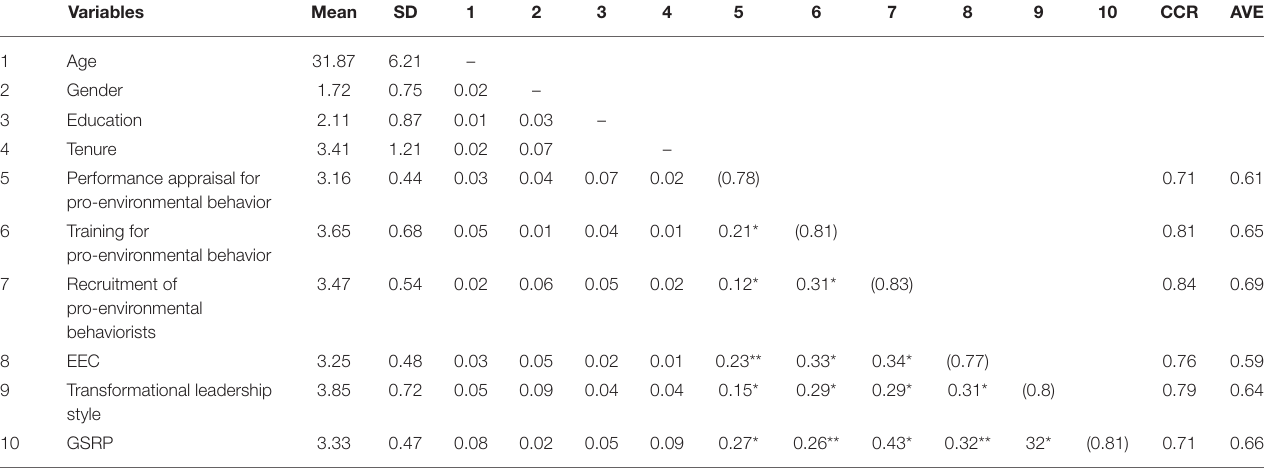
TABLE 2 | Pearson’s correlation, Composite Construct Reliability (CCR), and Average Variance Extracted (AVE).